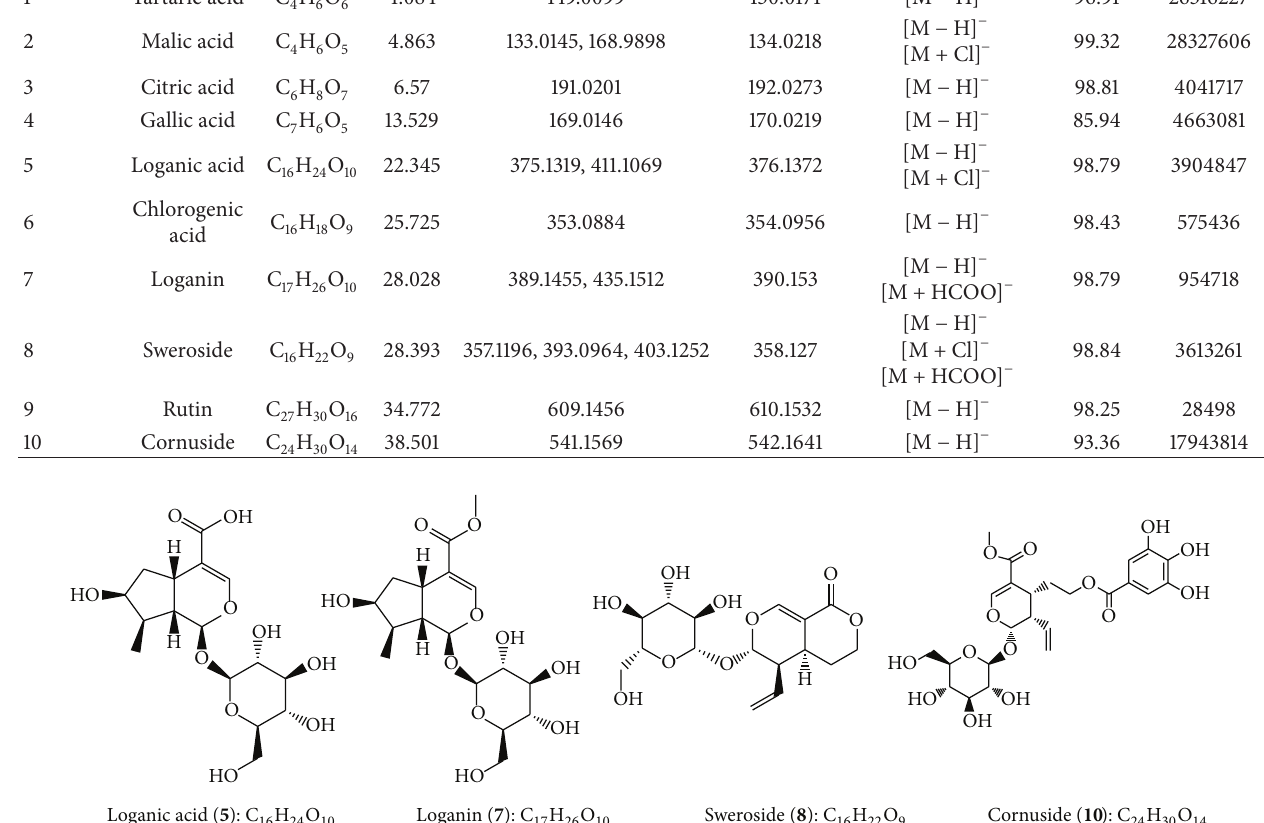
Figure 3: Chemical structures of iridoids identified in C. mas fruit by